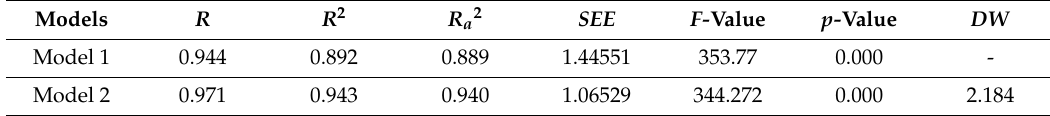
Table 4. Summary of the regression model based on the stepwise method.